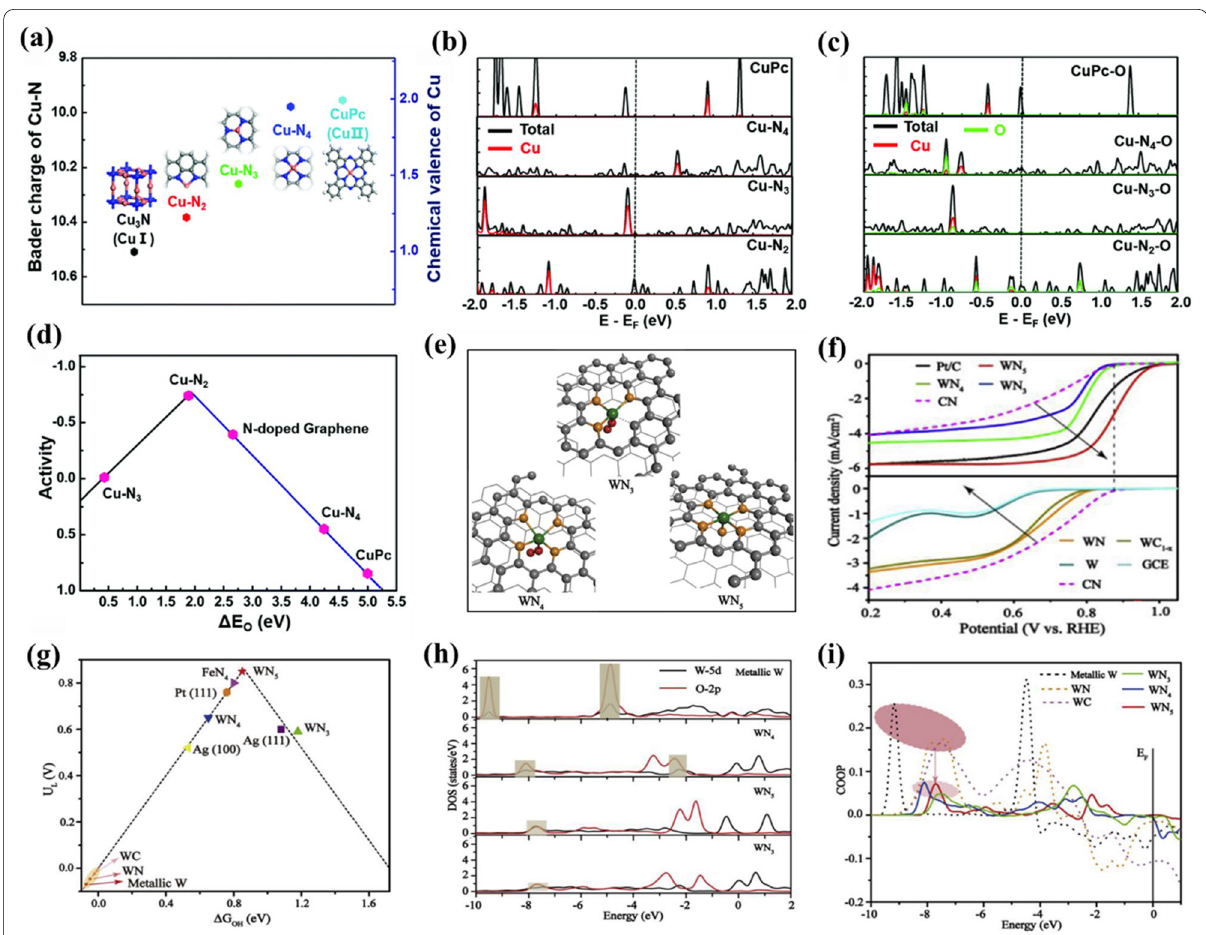
Fig. 4 a Bader charge and chemical valence of Cu centers for different structures: Cu 3 N bulk, Cu‑N 2 , Cu‑N 3 , Cu‑N 4 and CuPc molecule. b Total density of states (DOS) (black) for the CuPc, Cu‑N 4 , Cu‑N 3 and Cu‑N 2 , and projected DOS of Cu atoms (red) from them. c Total DOS (black) for one O adsorbed CuPc, Cu‑N 4 , Cu‑N 3 and Cu‑N 4 , and projected DOS of Cu atoms (red) and O atoms (green) from them. d Volcano plot of the relationship between ORR activity and Δ E O for Cu‑N 2 , Cu‑N 3 , Cu‑N 4 , CuPc and N‑doped graphene. e Schematic models of W‑N 3 , W‑N 4 and W‑N 5 , respectively. W (deep green), N (orange), O (red), and C (grey). f LSV curves of W‑N 3 , W‑N 4 , W‑N 5 , CN, and Pt/C catalysts in O 2 ‑saturated 0.1 M KOH. (g) Volcano plot of the relationship between the limiting potential ( U L ) and Δ G OH . h Local density of the states of W and O for *OH absorbed on metallic W, W‑N 3 , W‑N 4 and W‑N 5 . i Crystal orbital overlap population (COOP) analysis results for *OH absorbed on W‑N 3 , W‑N 4 and W‑N 5 . a – d Reproduced with permission from Ref. [95]. Copyright 2016, Royal Society of Chemistry. (e‑i) Reproduced with permission from Ref. [65]. Copyright 2019,